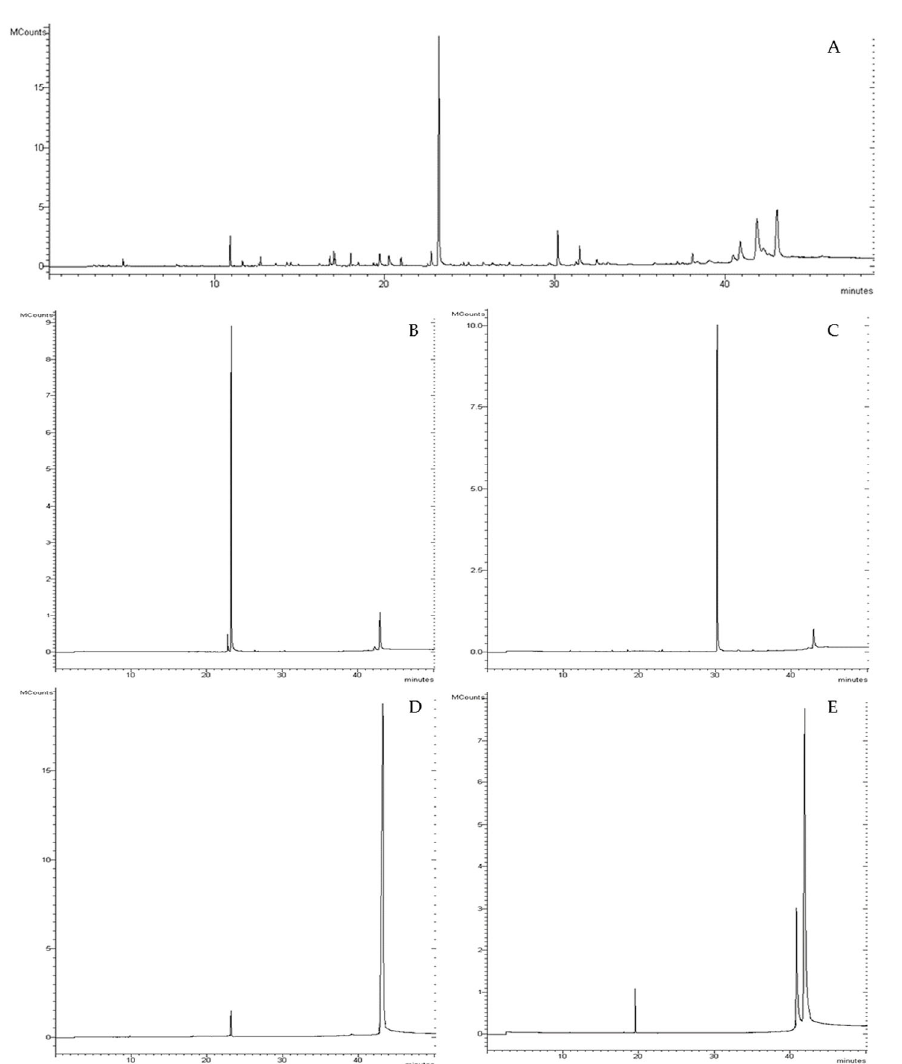
Figure 1. Chromatographic analysis of CP: ( A ) chromatogram of the total extract of CP; ( B – E ) chromatograms of fractions 1 to 4, respectively, obtained by flash chromatography.